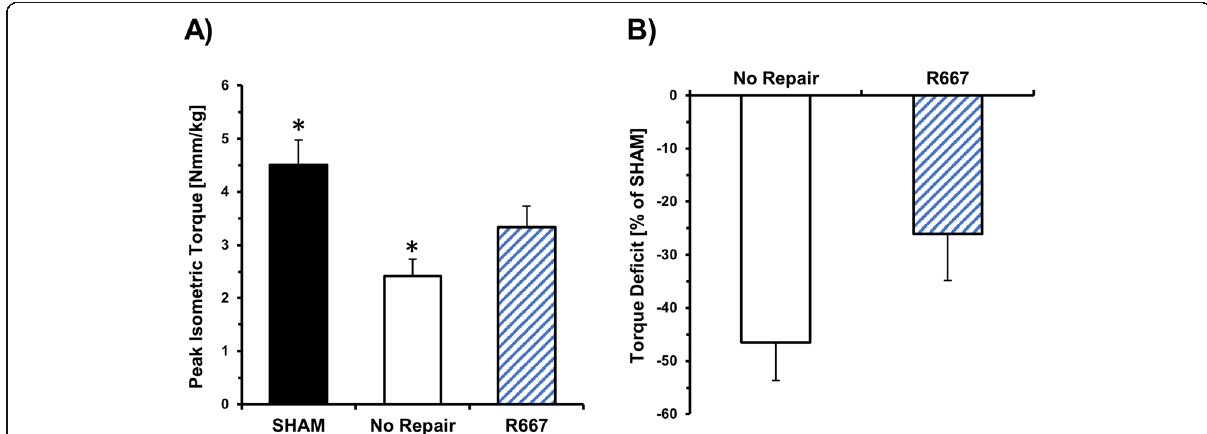
Fig. 1 Oral administration of R667 improves neuromuscular function 4 weeks after volumetric muscle loss. Peak isometric torque normalized to body weight (A) and percent functional deficit relative to SHAM control (B) demonstrate improved functional capacity in the R667 treatment group relative to the No Repair group. *Indicates significant difference between SHAM and No Repair with p < 0.05. Values are presented as Mean ±